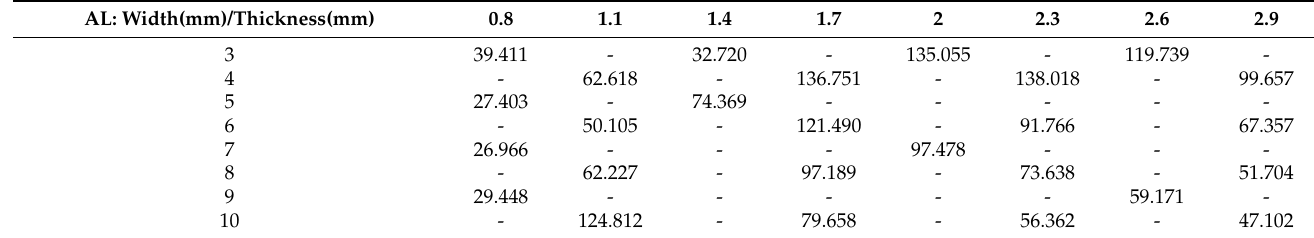
Table 2. Aluminum material specific energy absorption data.